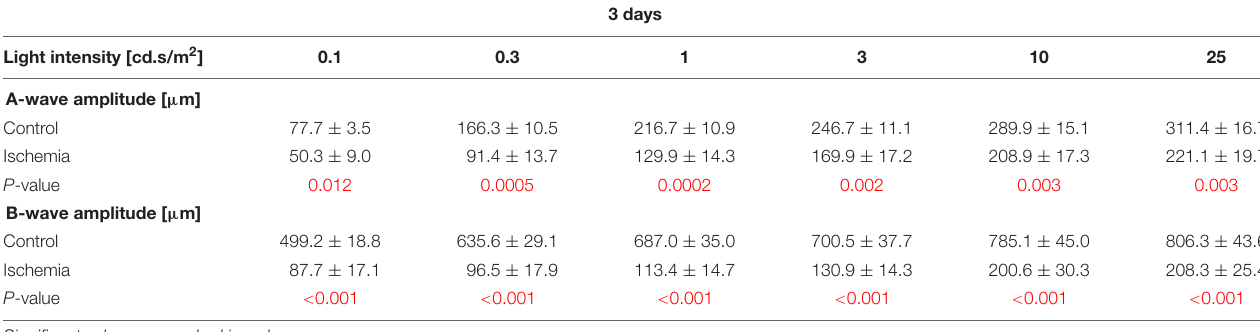
TABLE 3B | Analyses of the a-and b-wave amplitude of the ERG measurements (mean ± SEM) at 7 days. Light intensity [cd.s/m 2